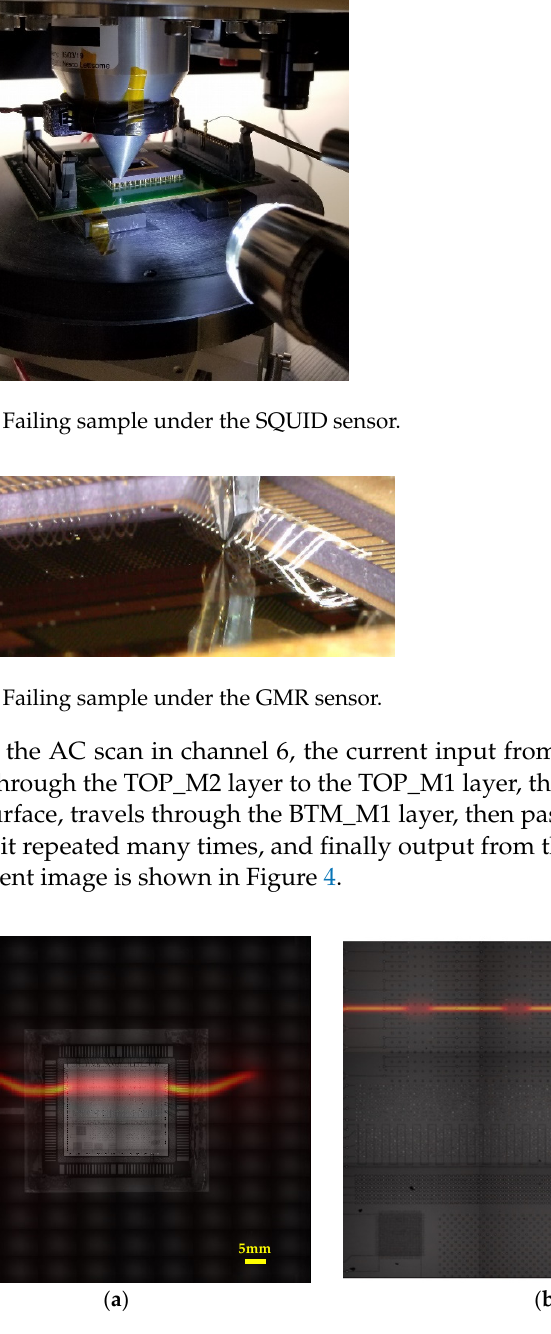
( a ) ( b ) Figure 5. RF scan from pin J12: ( a ) Reference sample; ( b ) Failed sample. Two RF probes were connected to pins J3 and J12 (Channel 6) at the same time. Some unusual behavior in the frequency sweep for the failing sample was noticed in comparison with the frequency sweep for the reference sample, as shown in Figure 6. The reference sample sweep has only one voltage dip, where the RF signal drops significantly. The failed sample sweep shows two dips at two different frequencies. The typical behavior is to only have a single dip. Scans are performed at different frequencies. ( a ) ( b ) Figure 6. RF frequency sweep curve: ( a ) Reference sample; ( b ) Failed sample. The reference sample current density data were taken at 43.0 MHz, with one probe on the left side and one probe on the right side. As shown in Figure 7, the signal shows no significant decay along with the green cursor at all three modes.